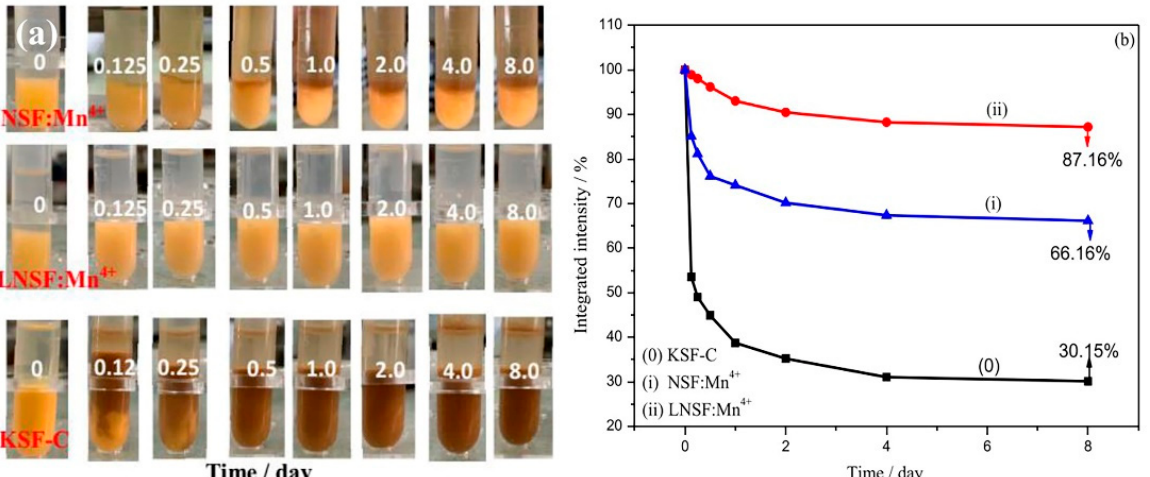
Figure 19. Na 2 SiF 6 : Mn 4+ , LiNaSiF 6 : Mn 4+ , K 2 SiF 6 : Mn 4+ -C soaked in deionized water for different times: ( a ) photographs under natural light; ( b ) relative PL changes. (Reprinted from Ref [60]. Copyright from American Chemical Society, 2022).